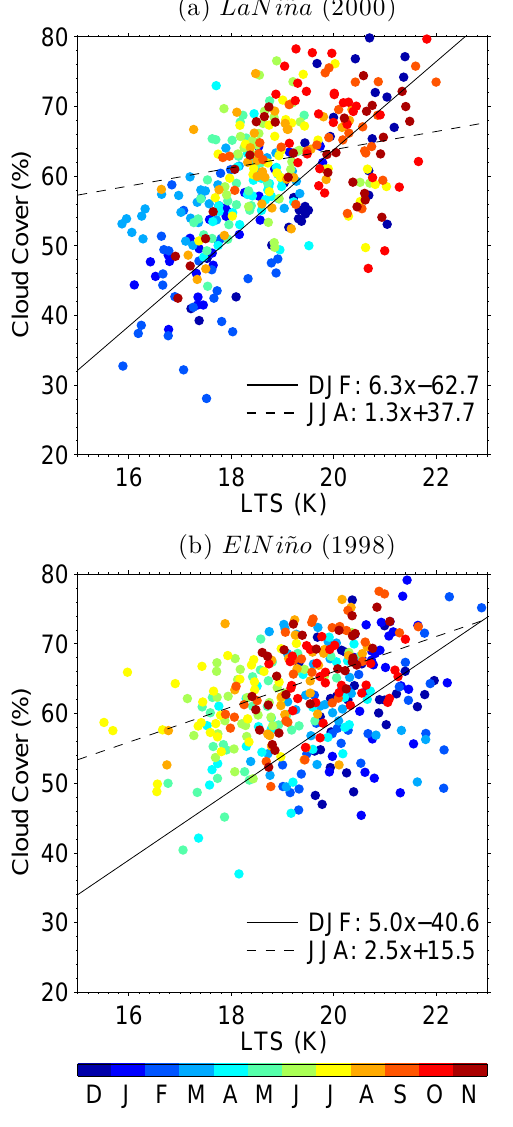
Fig. 8. Scatterplot of the daily area-averaged (refer to the box in Fig. 1) LTS versus daily area-averaged adjusted low cloud amount from all seasons of La Ni˜na year 2000 (a) and El Ni˜no year 1998 (b) , colored by the calendar months. Solid lines denotes best-fit linear regression for austral summer (DJF) and dashed for winter (JJA) of 2000 (a) and 1998 (b) .